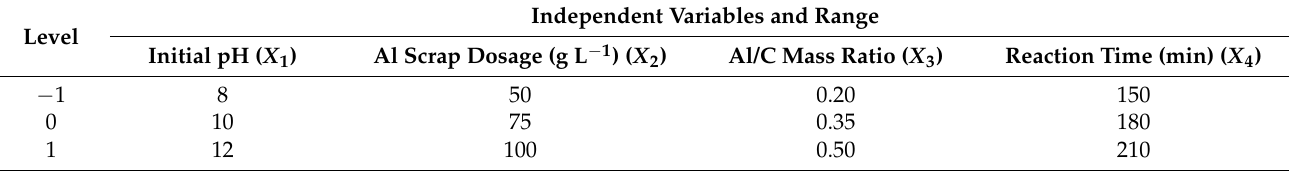
Table 1. Response surface experimental factors and level